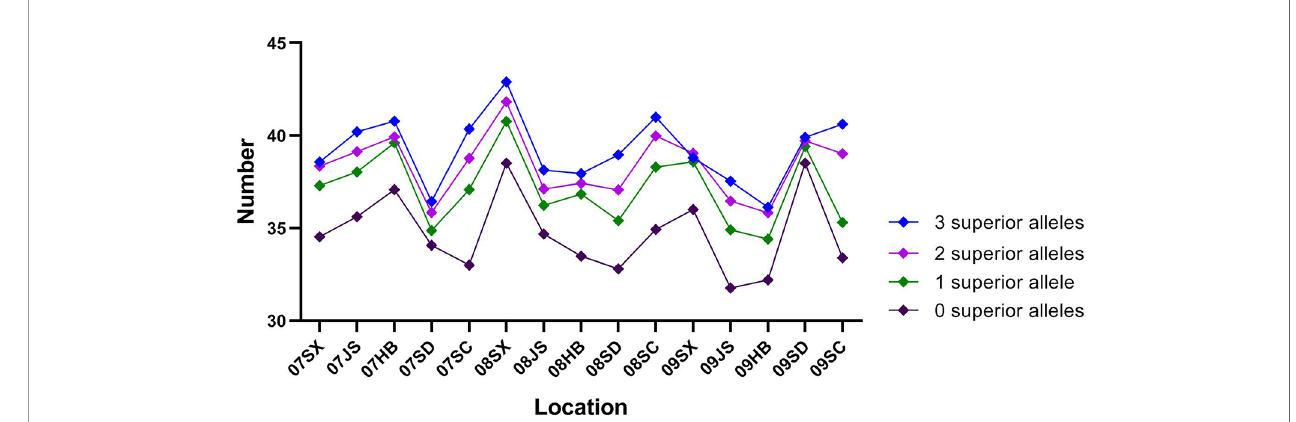
FIGURE 4 | The mean 1,000-kernel weight (TKW) of cultivars with 0 – 3 superior alleles in 15 environments.